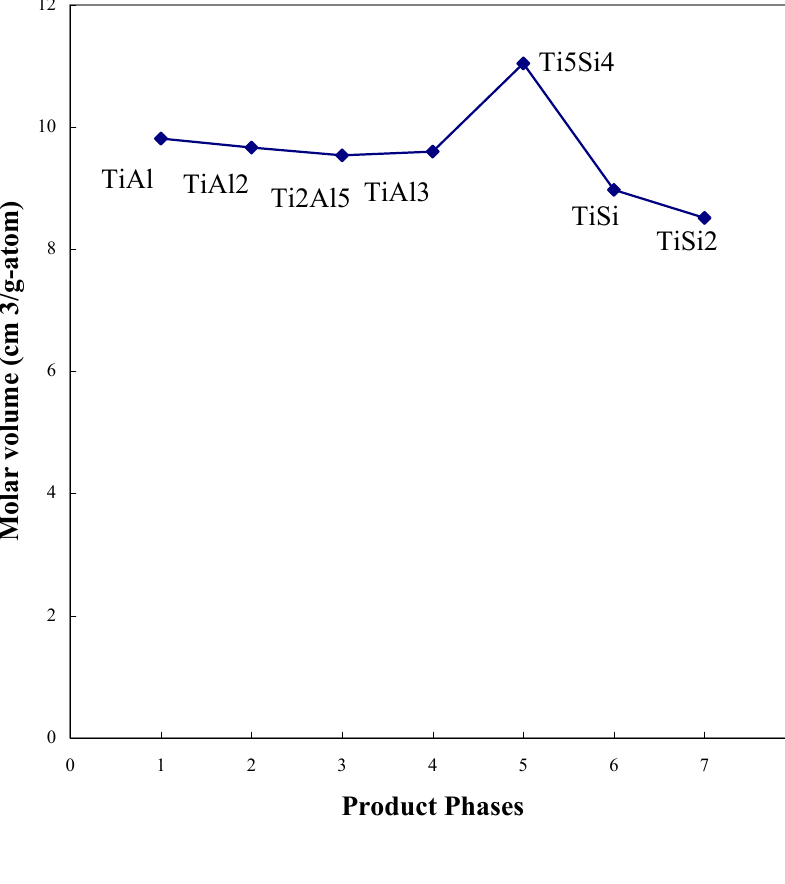
Figure 16. The molar volumes of the product phases of the TiAl/TiSi